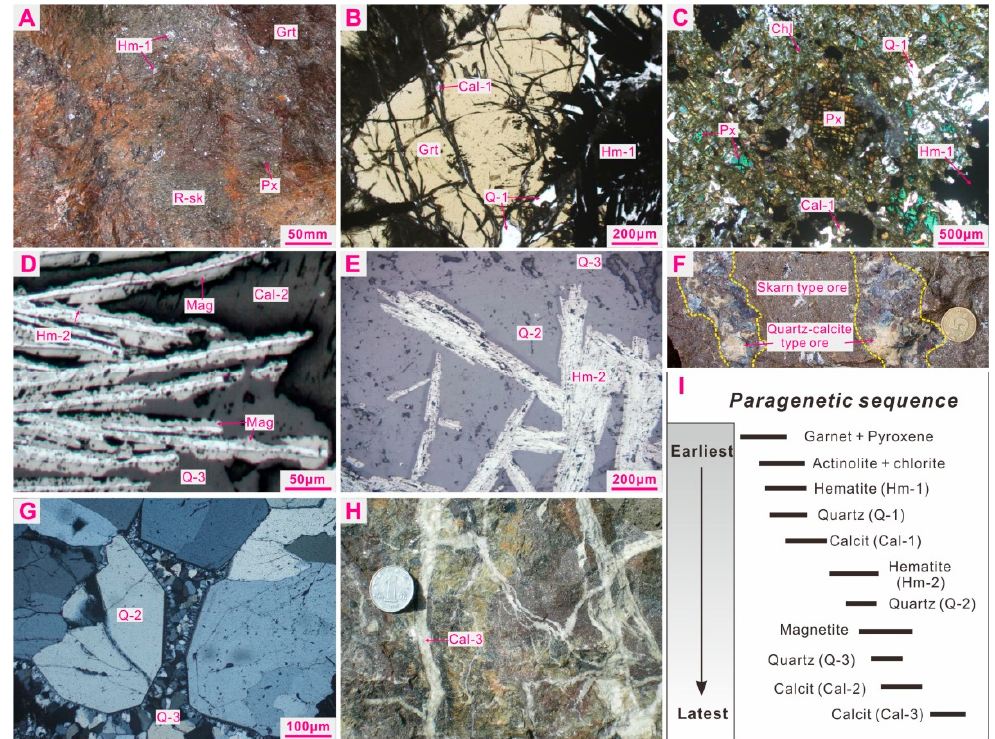
Figure 3. Photographs of representative samples from the Taochong iron deposit. ( A ) Skarn-type ore with metasomatic relict texture and disseminated structure. ( B ) Garnet (Grt) replaced by hematite (Hm-1), quartz (Q-1), and calcite (Cal-1) (plane polarized light). ( C ) Pyroxene (Px) replaced by chlorite (Chl), quartz (Q-1), calcite (Cal-1), and hematite (Hm-1) (crossed polars). ( D ) The quartz–calcite-type ore occurs as a vein and cuts the skarn-type ore. ( E ) Elongate euhedral crystals of hematite (Hm-2) intergrown with quartz (Q-2) (reflected light). ( F ) Replacement of hematite by magnetite (Mag) along the rims (reflected light). ( G ) Fine-grained quartz (Q-3), which is associated with magnetite, filled in inter-granule spaces among the relatively large and euhedral quartz crystals (Q-2) that are associated with hematite (Hm-2) (crossed polars). ( H ) Calcite veins cut across the orebody. ( I ) Paragenetic sequence of the Taochong deposit. R-Sk: retrograde skarn minerals.